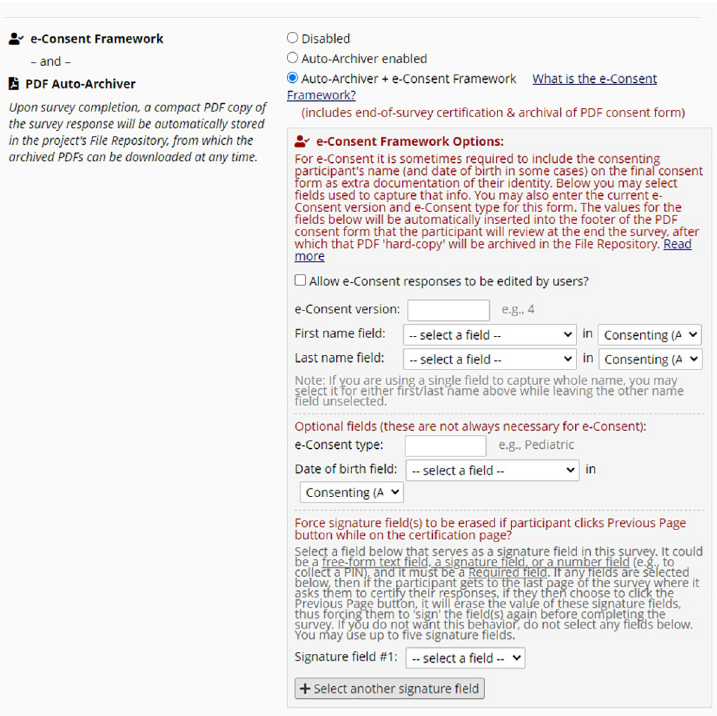
Fig 1. Auto archiver & eConsent framework ENABLED in survey setting, to capture all responses in a pdf, and maintain versioning of consent documents.